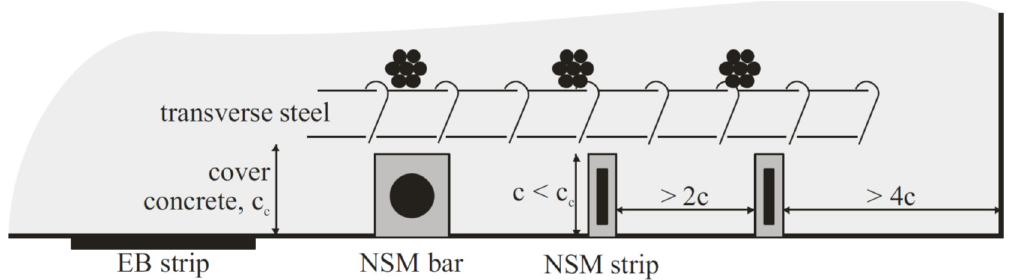
Figure 2. Schematic of EB and NSM bar and NSM strips for the strengthening of reinforced concrete (RC) members [46].